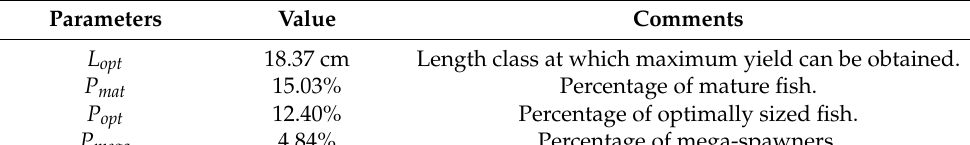
Table 6. The estimated values of Forese (2004) [26] length-based indicators.